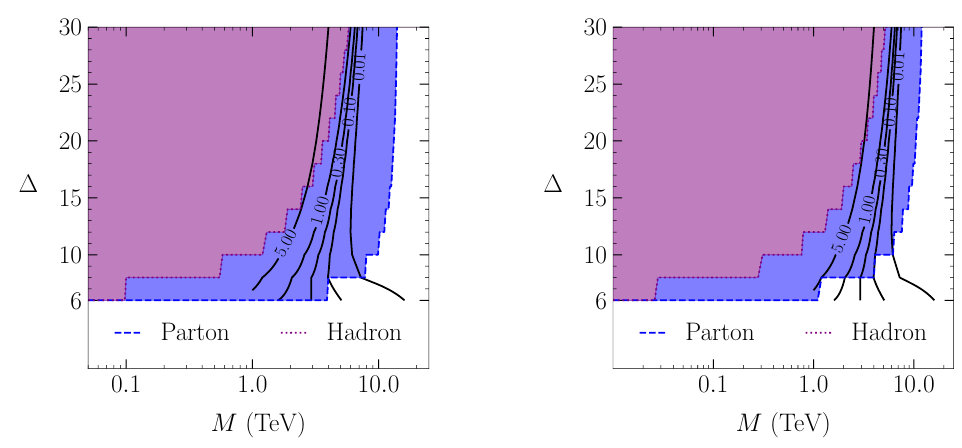
Figure 20 . A comparison of the perturbative unitarity results against the s -channel cross section predictions for two choices of the UV parameters: λ q = 2 [left] and λ q = 2 / (4 π ) [right] in the case that the final state particles have a mass of 10 GeV. The shaded regions are the perturbative unitarity bounds, while the contours show power counting